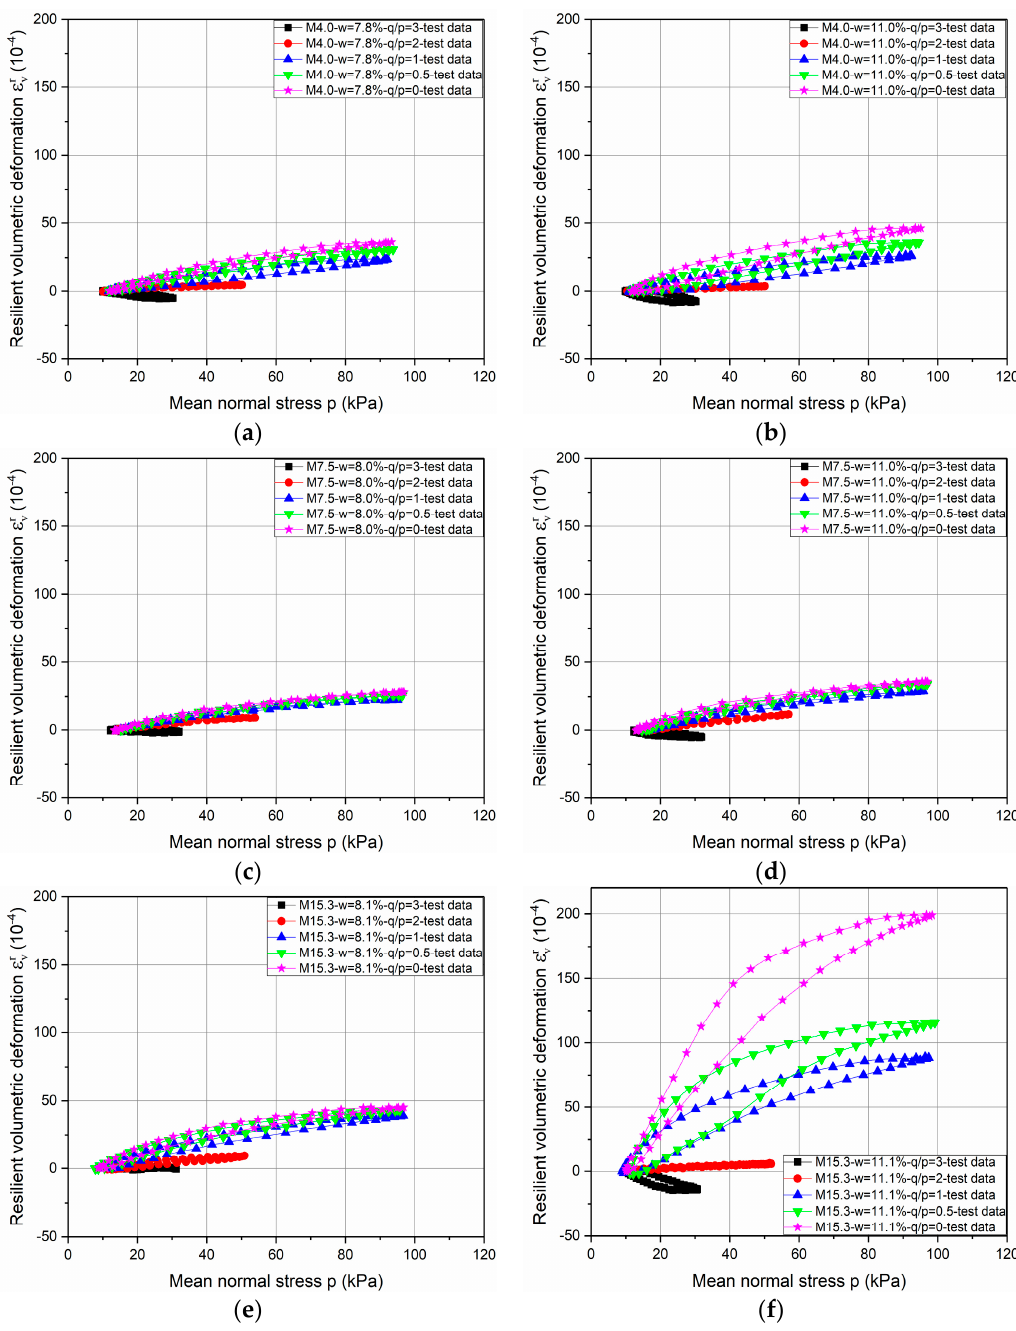
Figure 3. Evolution of resilient volumetric deformation ε vr for three different Missillac sands—M4.0, M7.5, and M15.3—with water contents of w = 8% and w = 11%. (a) M4.0- w = 7.8%; (b) M4.0- w = 11.0%; (c) M7.5- w = 8.0%; (d) M7.5- w = 11.0%; (e) M15.3- w = 8.1%; ( f ) M15.3- w = 11.1%.